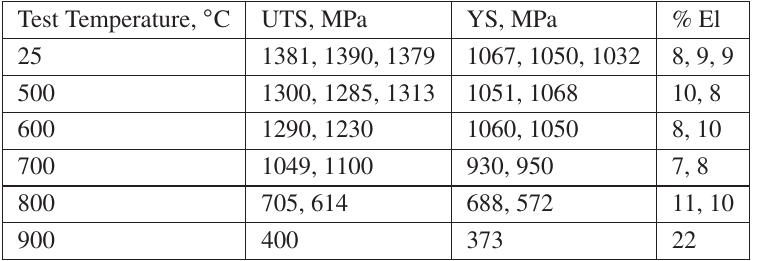
Table 5. Mechanical properties of heat treated sheet at different